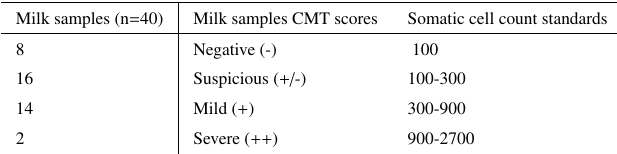
Table 1. CMT Score and Somatic cell counts of milk